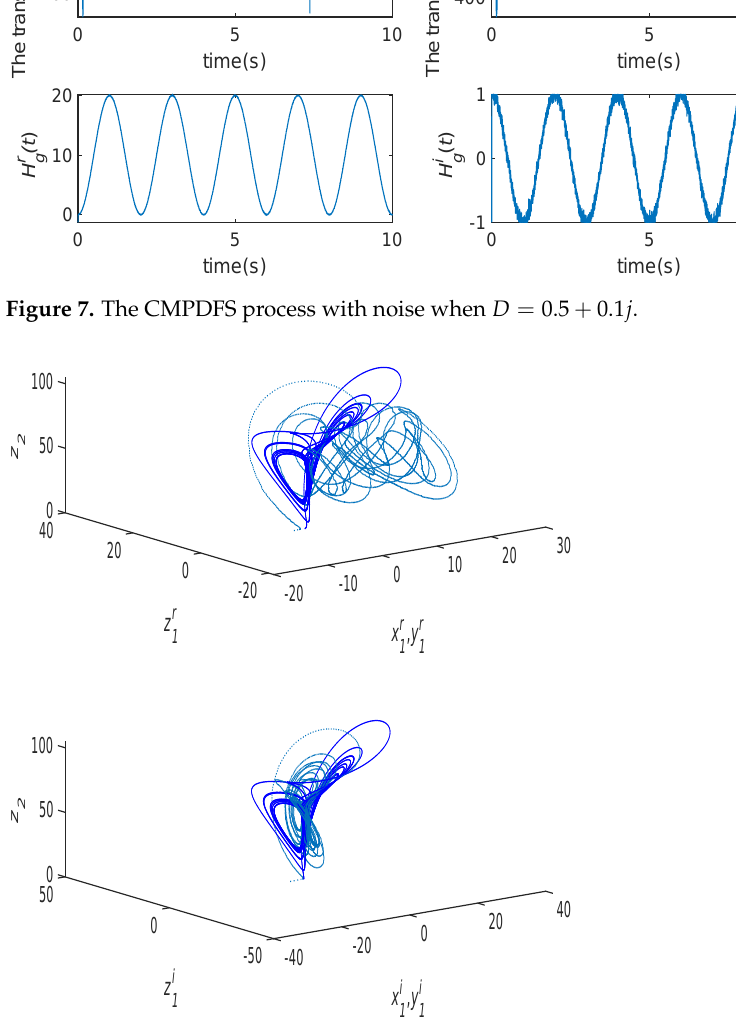
Figure 8. The projection diagram of chaotic systems L 1 and L 2 with noise A =